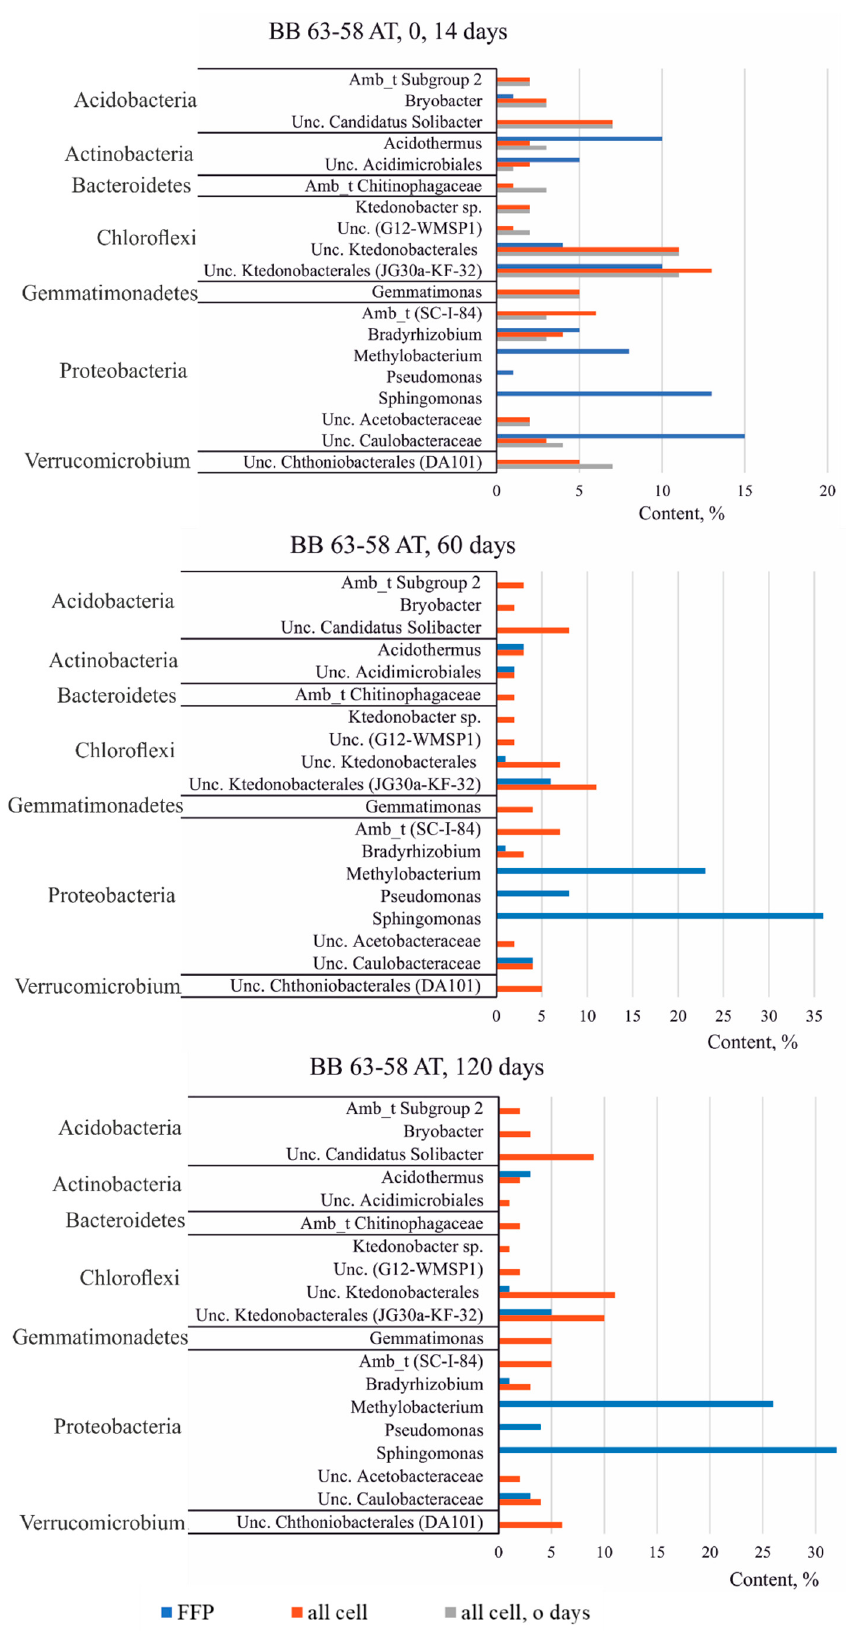
Figure 6. Distribution of dominant groups during succession in the horizon AT, BB 63–58 profile, 5 °C (phyla with content greater than 2% are presented).